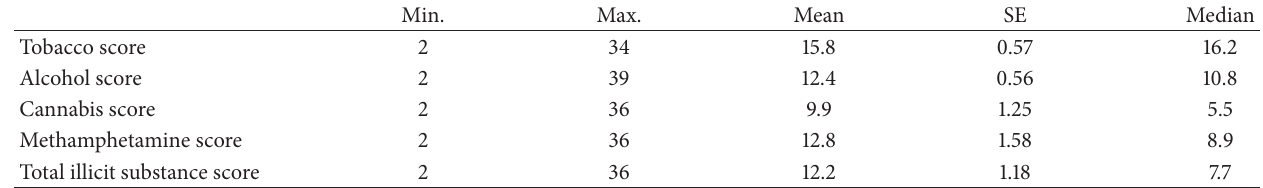
Table 4: Alcohol, Smoking, and Substance Involvement Screening Test (ASSIST): substance involvement scores.